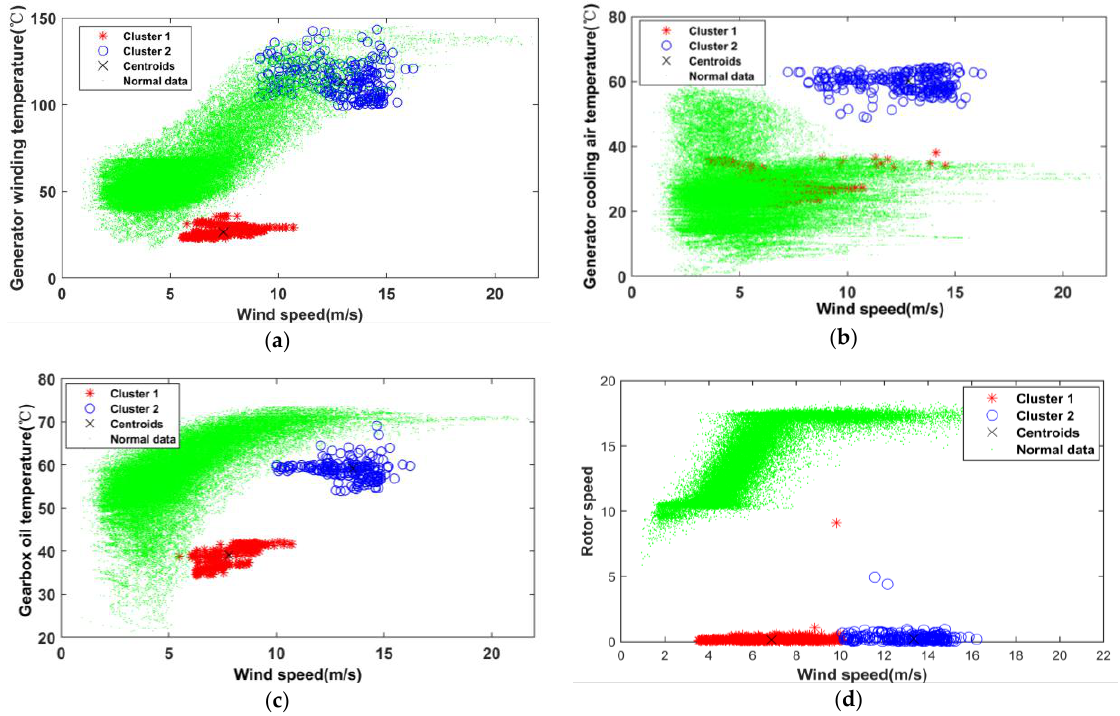
Figure 7. Characteristic quantities: ( a ) wind speed vs. generator winding temperature u1; ( b ) wind speed vs. generator cooling air temperature; ( c ) wind speed vs. gearbox oil temperature; ( d ) wind speed vs. rotor speed.